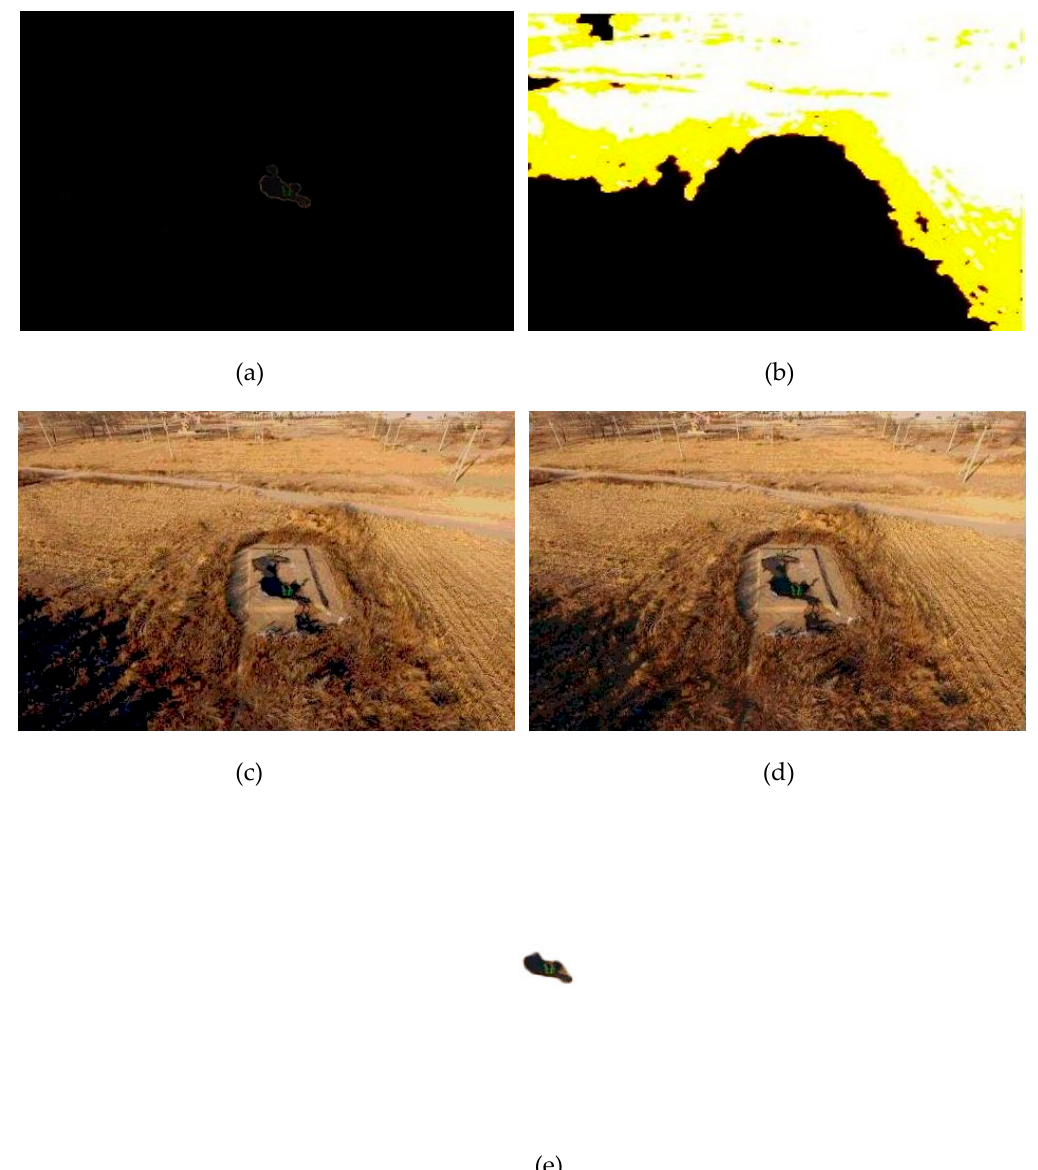
Figure 20. The segmentation results of oil pollution4 image. ( a ) 3DPCNN-HSOA; ( b ) LSA; ( c ) MS; ( d ) GLCM; and ( e ) Ground